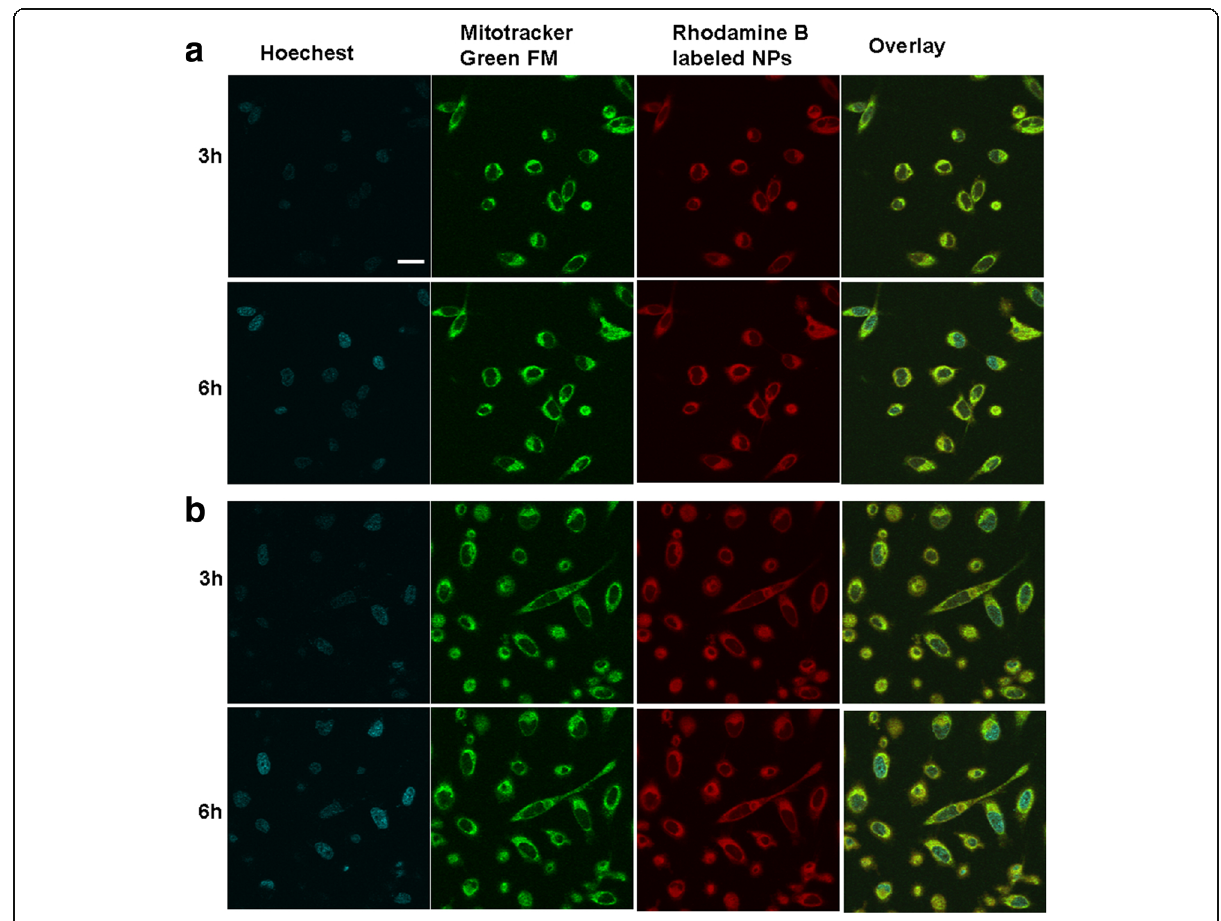
Fig. 2 The in vitro cellular distribution of BSA NPs after being incubated with different tumor cells. Fluorescent image of SMMC-7721 cells ( a ) and Plc cells ( b ). Scale bar , 100 μ